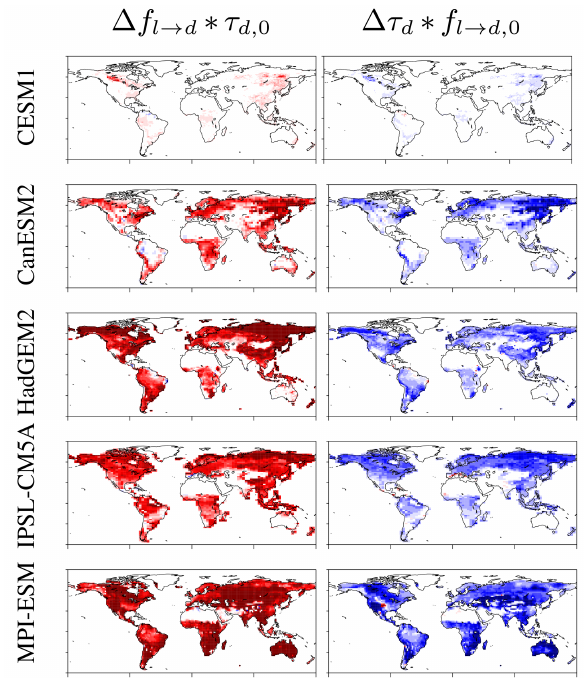
Figure 8. Responses of linearized equilibrium dead (soil and lit- ter) carbon pools (kgCm − 2 over the interval of CO 2 doubling) in fully coupled (1pctCO2) run. Left column shows productivity- driven changes to c C d . Right column shows turnover-driven changes to c C d .